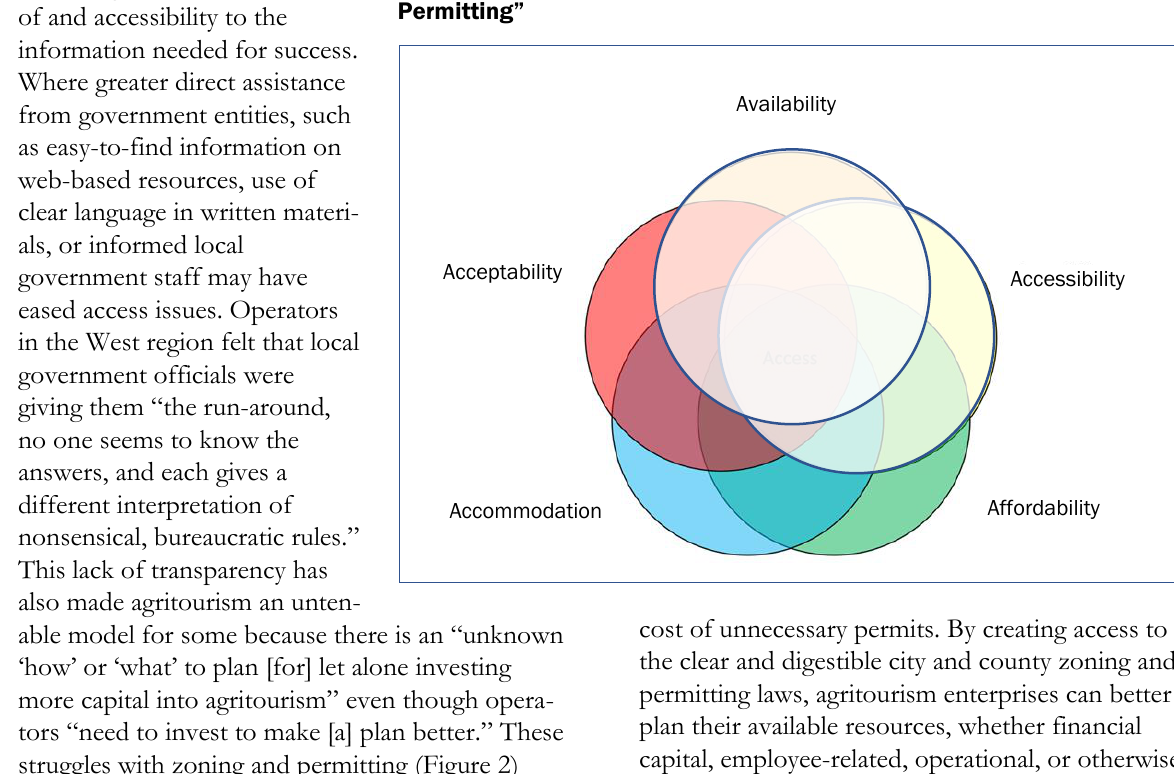
Figure 2. Limits to Access Due to “City and County Zoning